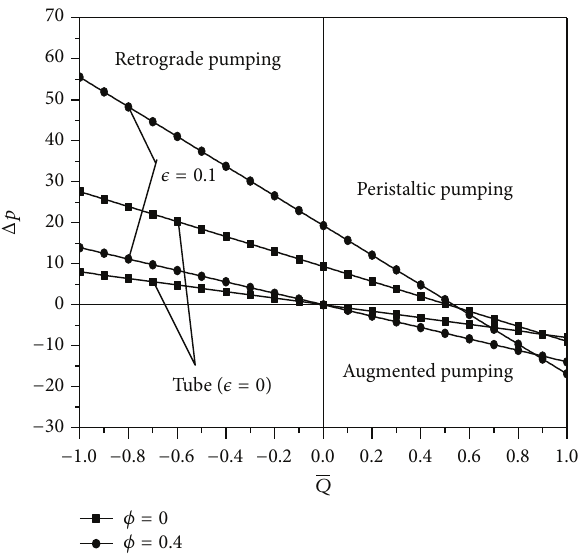
Figure 14: Wall shear stress 𝜏 13 at the outer wall versus 𝑧 with different values of 𝜙 and Wi at 𝜖 = 0.1 , 𝑄 = 1 , 𝛿 = 0.08 , and Re = 10 .